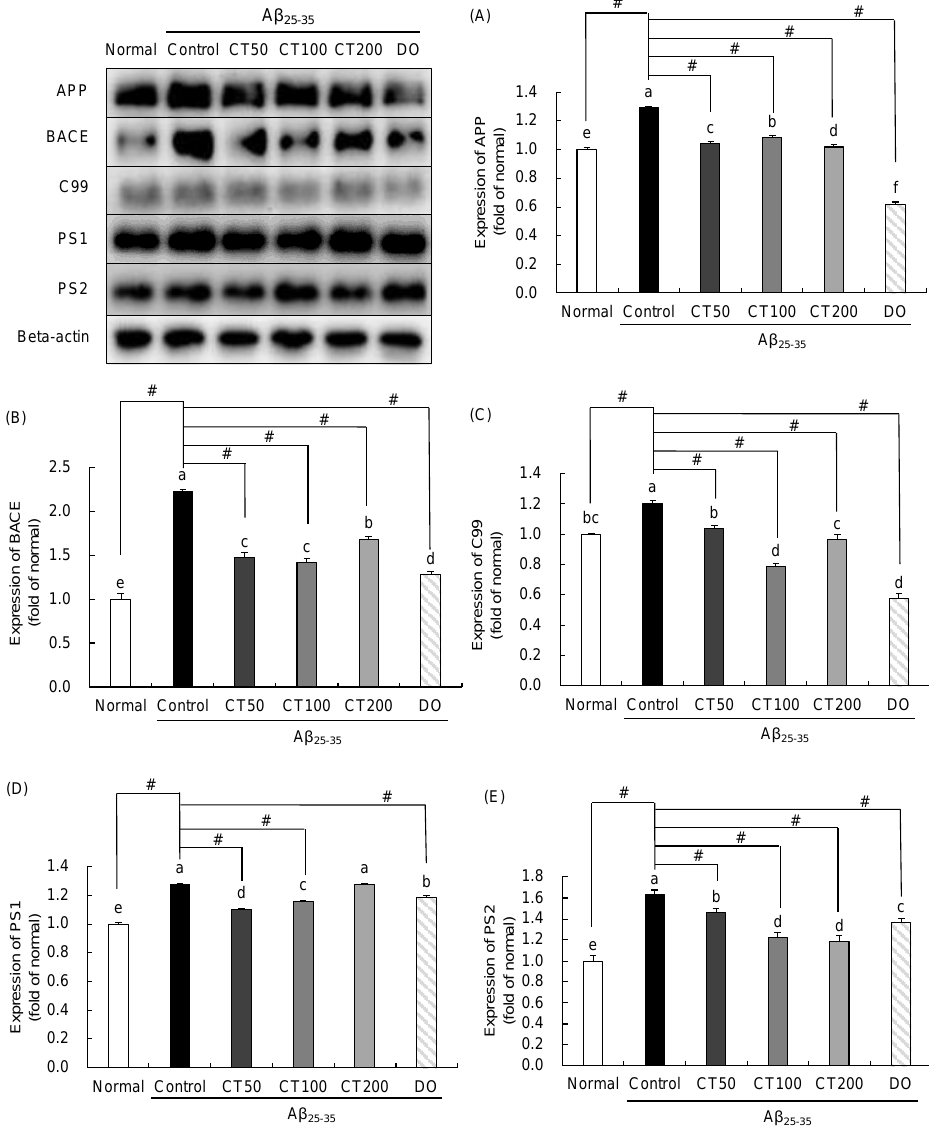
Figure 6. Effect of combination of Carthamus tinctorius L. seed and Taraxacum coreanum (CT) on APP processing-associated protein expression. Expression of APP ( A ), BACE ( B ), C99 ( C ), PS1 ( D ), and PS2 ( E ). Values are mean ± SD. a–f Means indicated with different letters are significantly different by Duncan’s multiple range test; # p < 0.05 vs. control group. Normal: 0.9% NaCl + water; Control: Aβ 25-35 + water; CT50: Aβ 25-35 + CT (50 mg/kg/day); CT100: Aβ 25-35 + CT (100 mg/kg/day); CT200: Aβ 25-35 + CT (200 mg/kg/day); DO: Aβ 25-35 + donepezil (5 mg/kg/day).